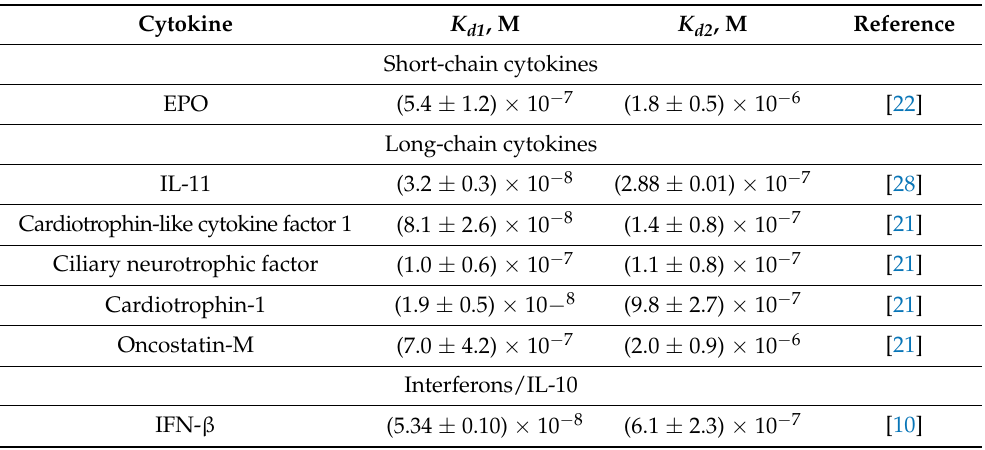
Table 1. The literature data on parameters of the heterogeneous ligand model (1), describing the SPR data on kinetics of interaction between Ca 2+ -loaded S100P and four-helical cytokines at 25 ◦ C (cytokine immobilization on the sensor chip surface by amine coupling).